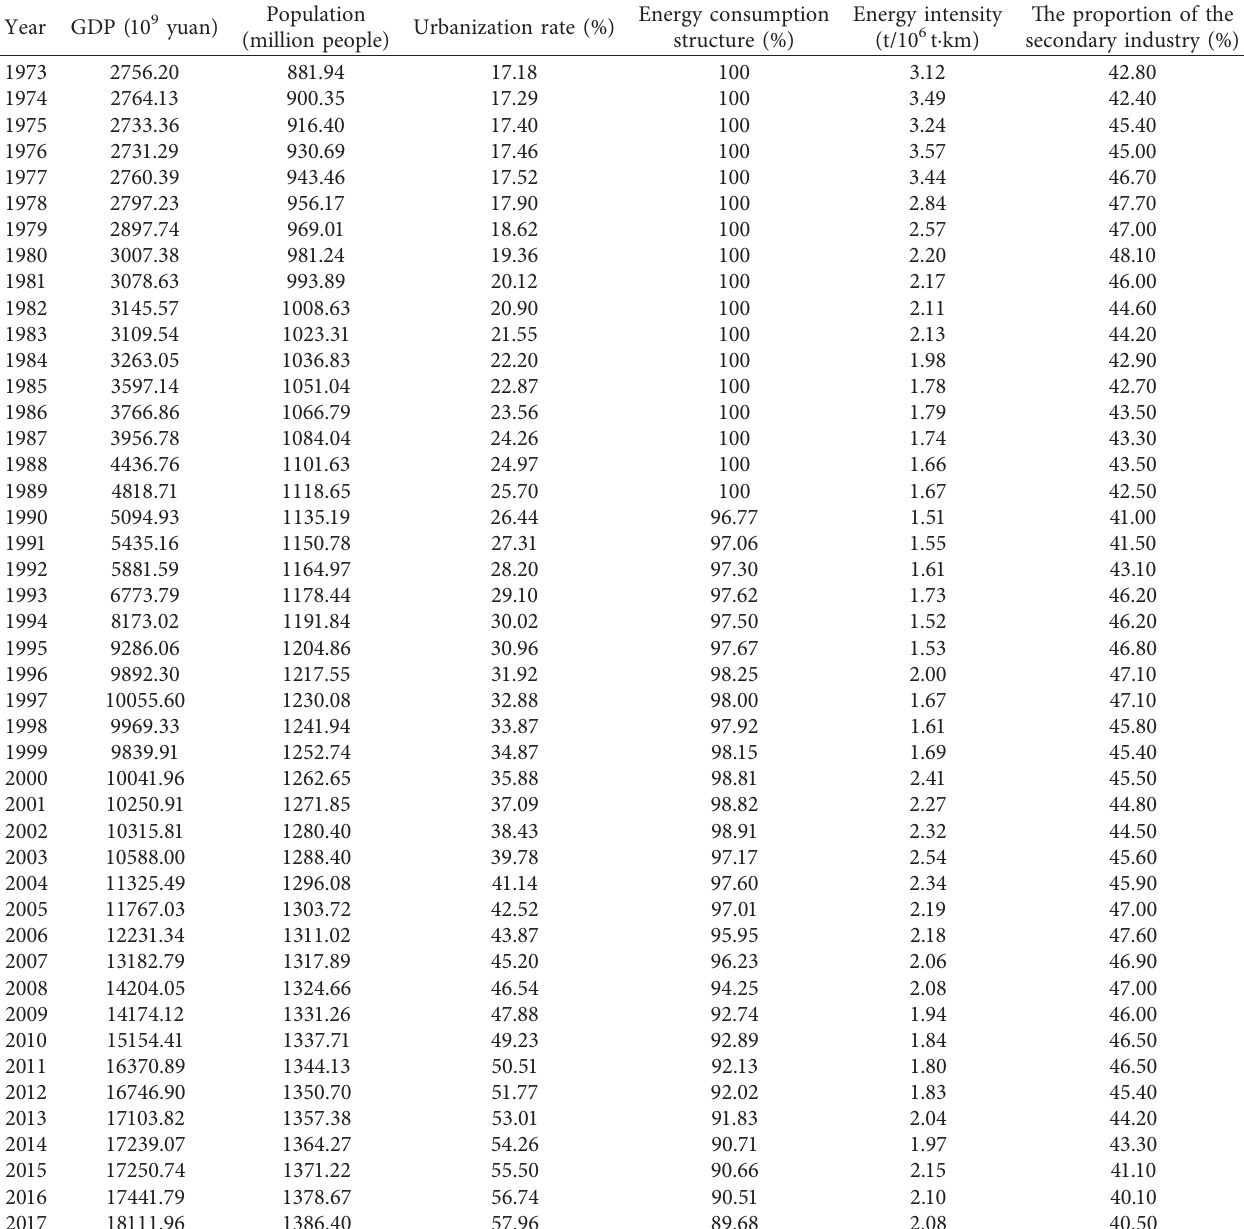
Table 3: Data of traffic carbon dioxide emissions and their influencing